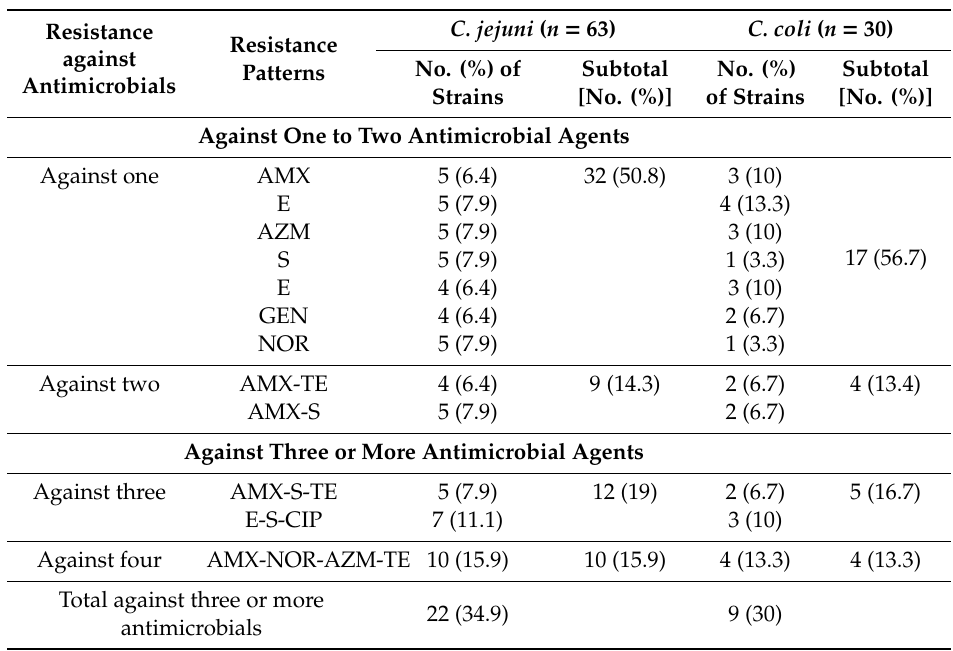
Table 5. Distribution of antimicrobial resistance pattern among the isolated C. jejuni ( n = 63) and C. coli ( n = 30) strains from broiler farms. Resistance Resistance against Subtotal No. (%) Subtotal Patterns No. (%) of Antimicrobials Strains [No. (%)] of Strains [No. (%)] Against One to Two Antimicrobial Agents Against one AMX 5 (6.4) 32 (50.8)